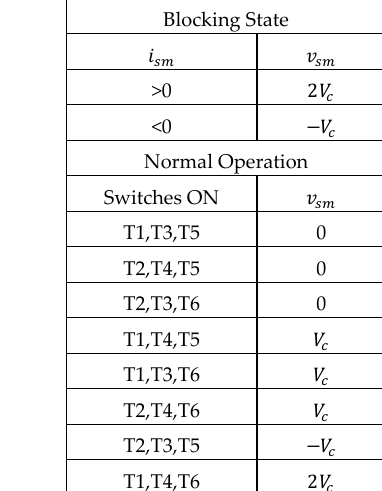
Figure 16. MSM 393 Figure 16.